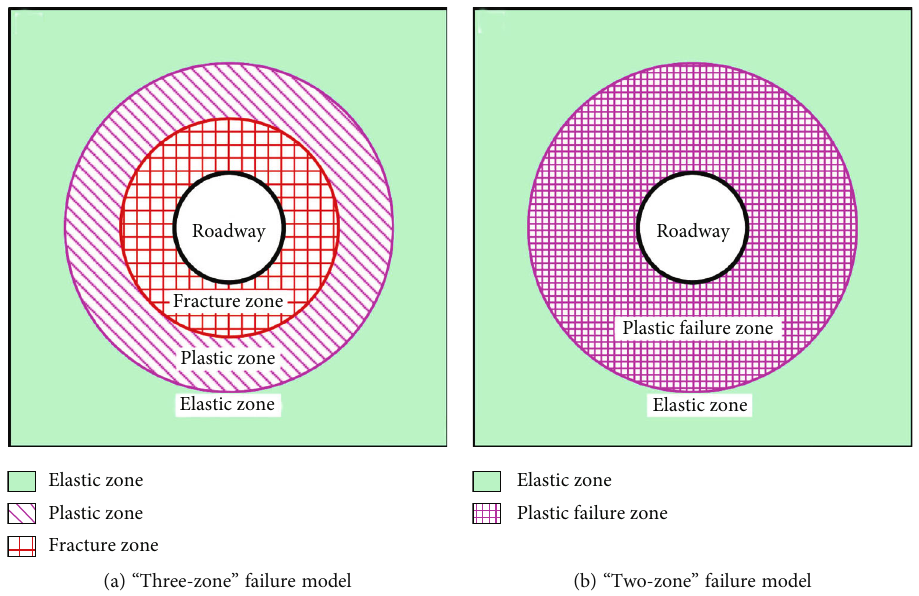
Figure 1: The failure zoning model of the roadway after stress redistribution (from [27] Huang et al.,